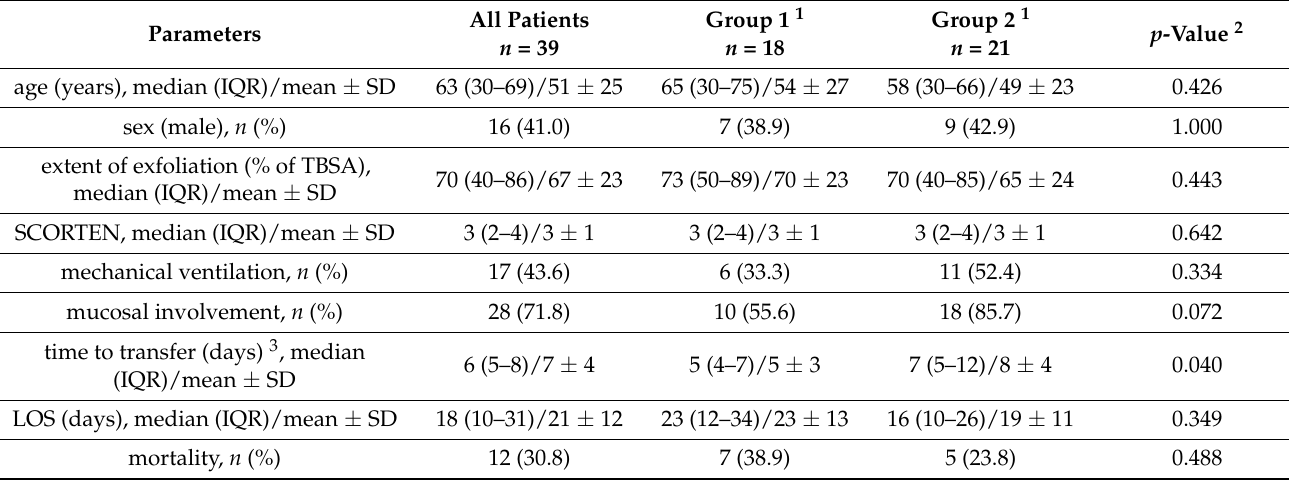
Table 1. General epidemiological and clinical parameters of patients with toxic epidermal necrolysis (TEN) in the context of the use of antibiotics before TEN